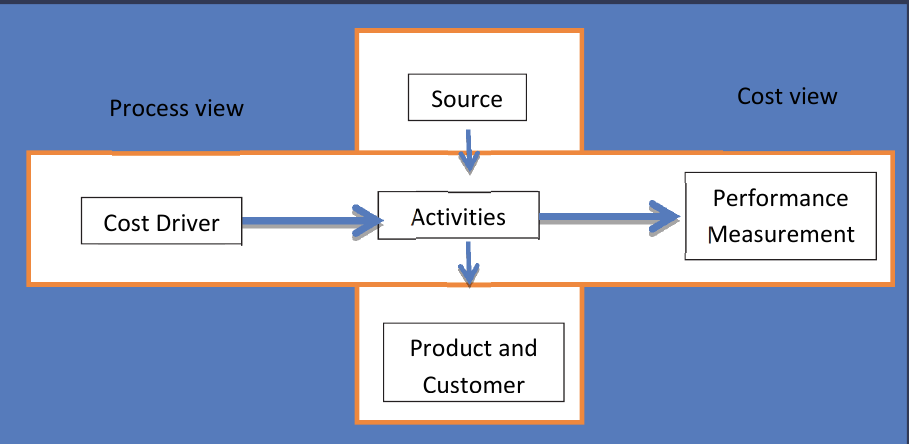
Fig. 1. Activity-based-costing